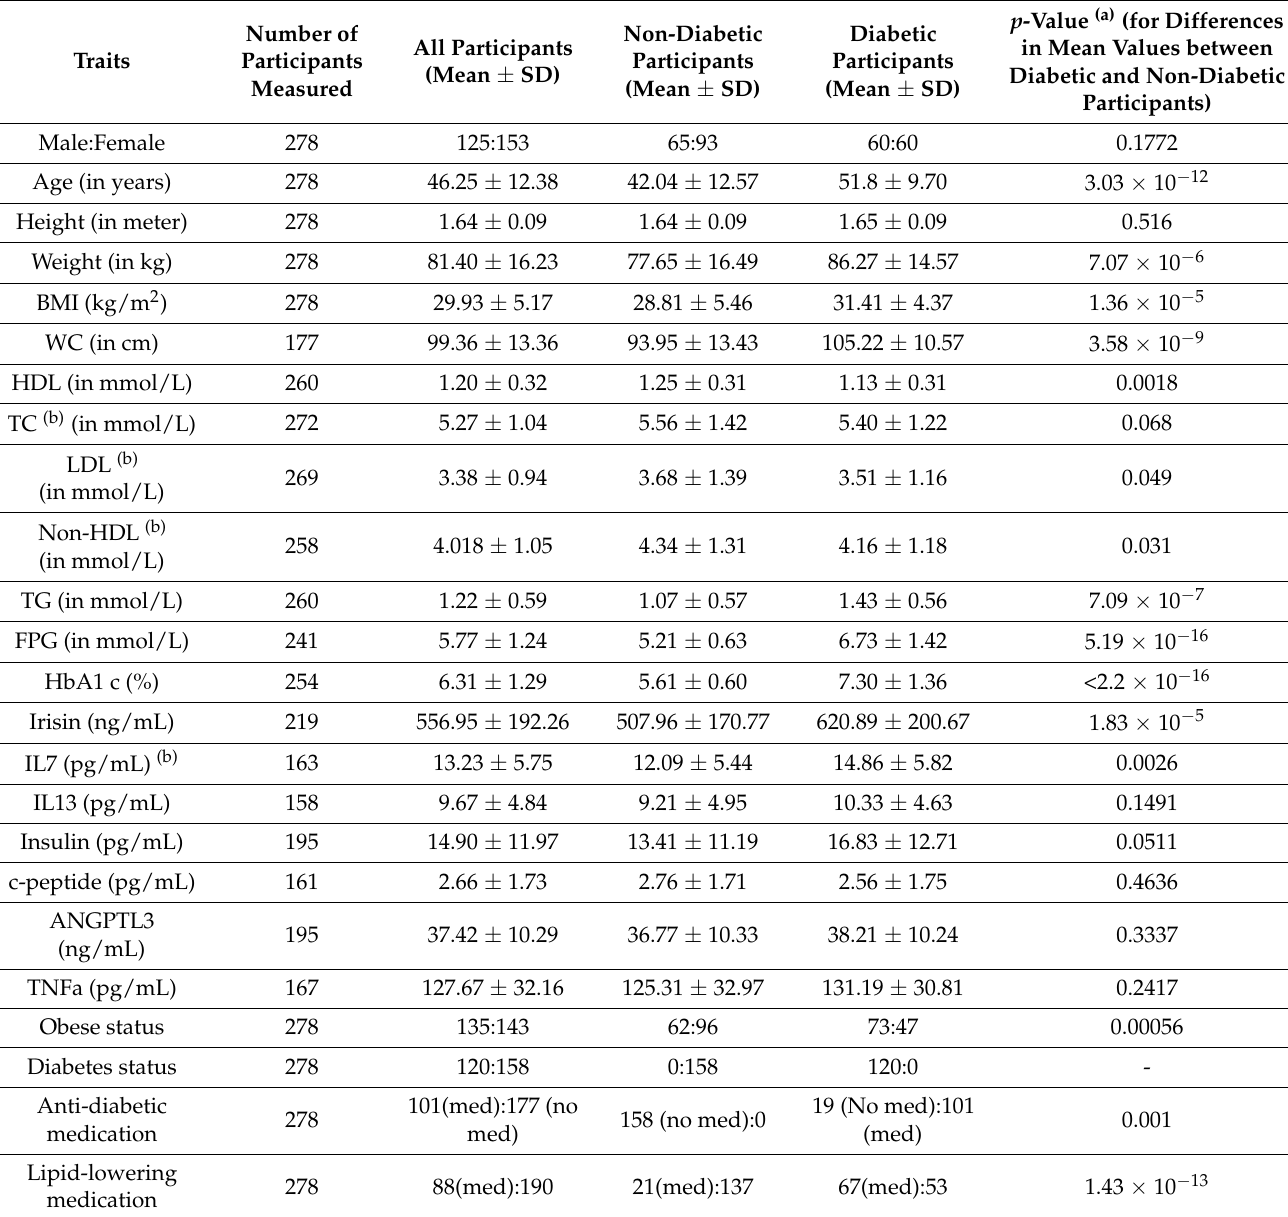
Table 1. Clinical characteristics of the study cohort. A total of 28 traits and biomarkers were considered in the study. p -Value (a) (for Differences Diabetic Non-Diabetic Number of All Participants in Mean Values between Participants Participants Traits Participants (Mean ± SD) Diabetic and Non-Diabetic (Mean ± SD) (Mean ± SD) Measured Participants)